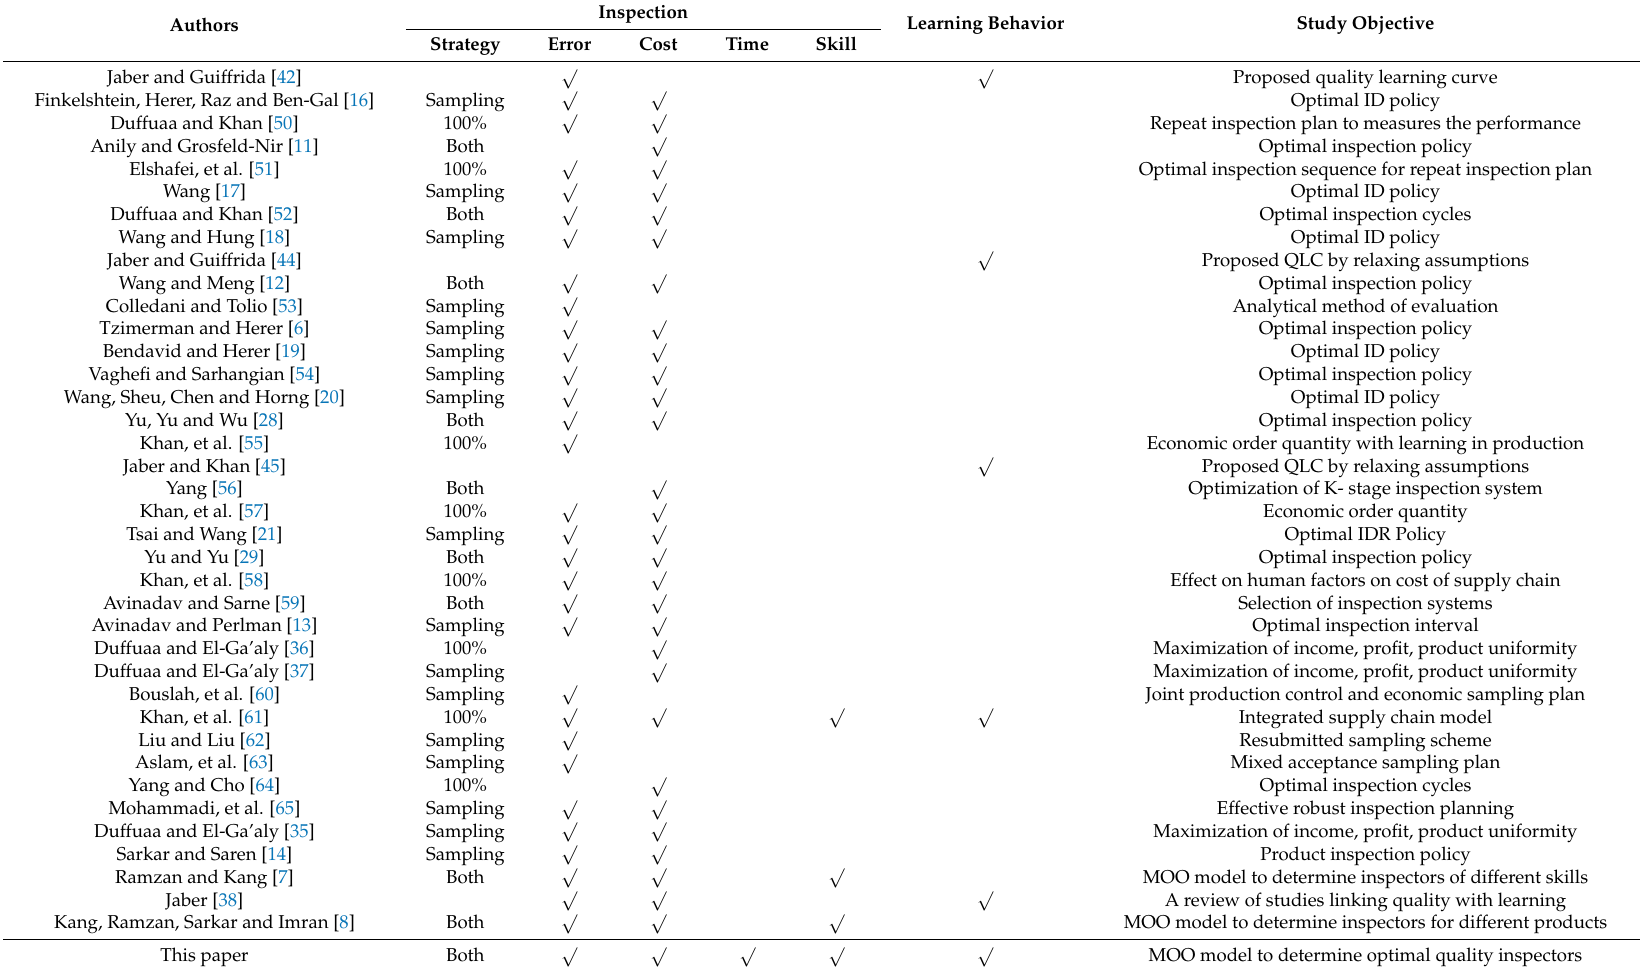
Table 1. Summary of contribution made by previous